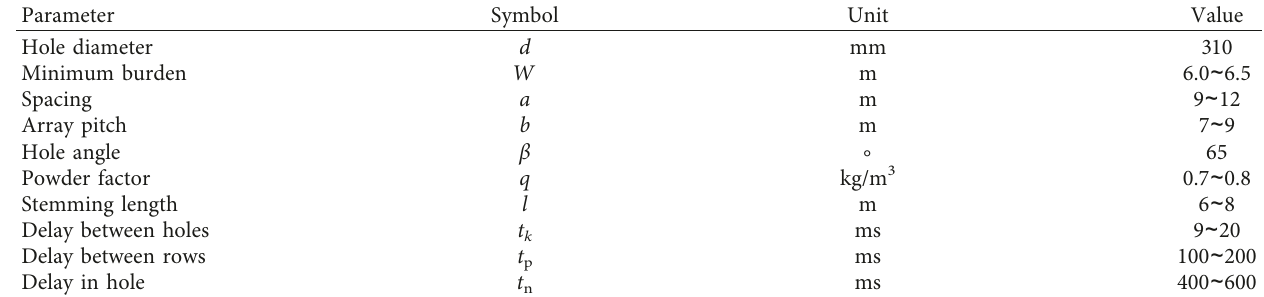
Table 2: Cast-blasting parameters.